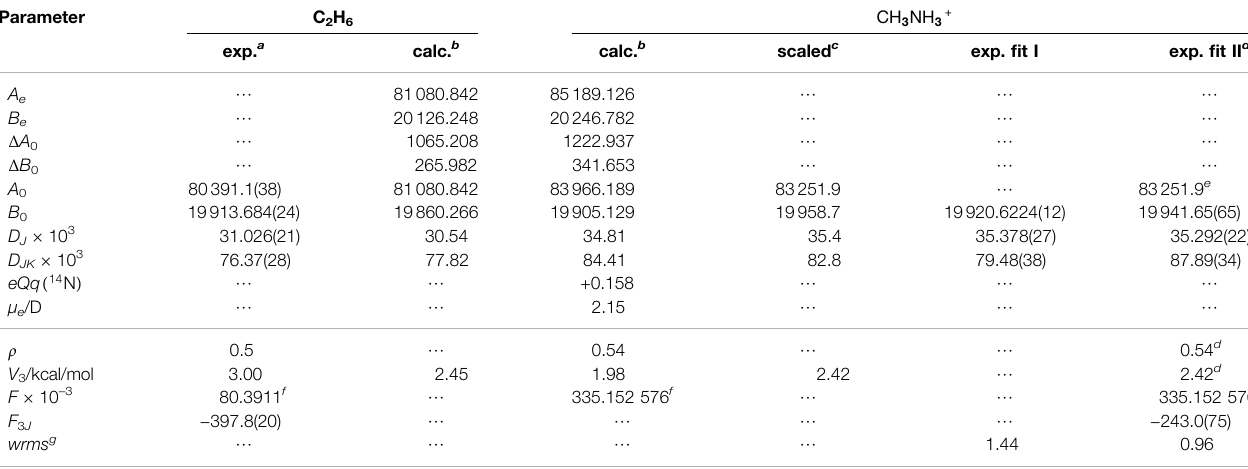
TABLE1| Calculatedandexperimentalspectroscopicparameters(inMHz,unlessnotedotherwise)ofCH 3 NH 3 + .Twoexperimental fi tstothemeasureddataarepresented, one ( fi t I) ignoring the torsional motion, and one ( fi t II) including torsional motion. Numbers in parentheses are one standard deviation in units of the last digit.